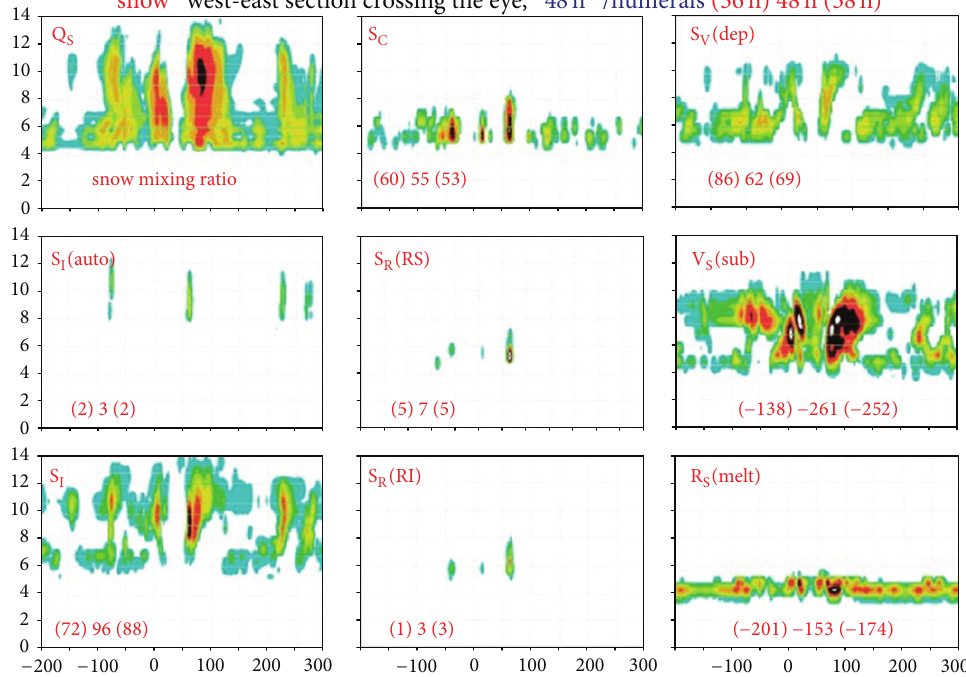
Figure9:Verticalcrosssection(west-eastsection)ofthemixingratioofsnow(upper-leftpanel)andeightprocessesofthecloudmicrophysics relatedtosnow(otherpanels)at48 hincaseICE.Thesectioncrossesthecenteroftheeye.Threenumeralsineachpanelindicatethemagnitude of each process averaged in the area enclosed by the red square in Figure 6, at 36 h, 48 h, and 58 h. See text for S I (auto), S I , and others.